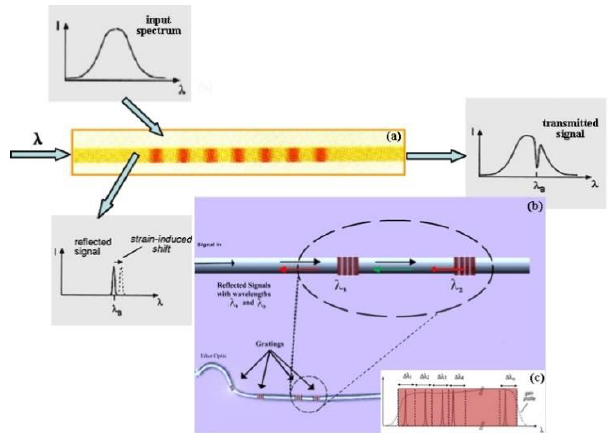
Figure 1. Schematic diagram of the operation and Select configuration diagram of the FBG sensor. ( a ) Working principle of Fiber Bragg grating (FBG); ( b ) wavelength division multiplexing (WDM) technology for FBG sensors; ( c ) Selection and configuration of FBG sensors.